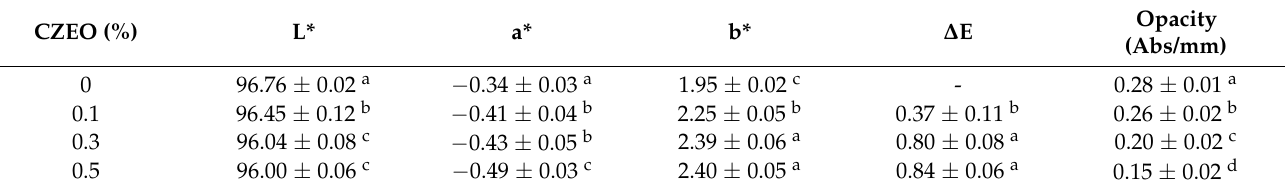
Table 2. Optical properties of GBS films containing